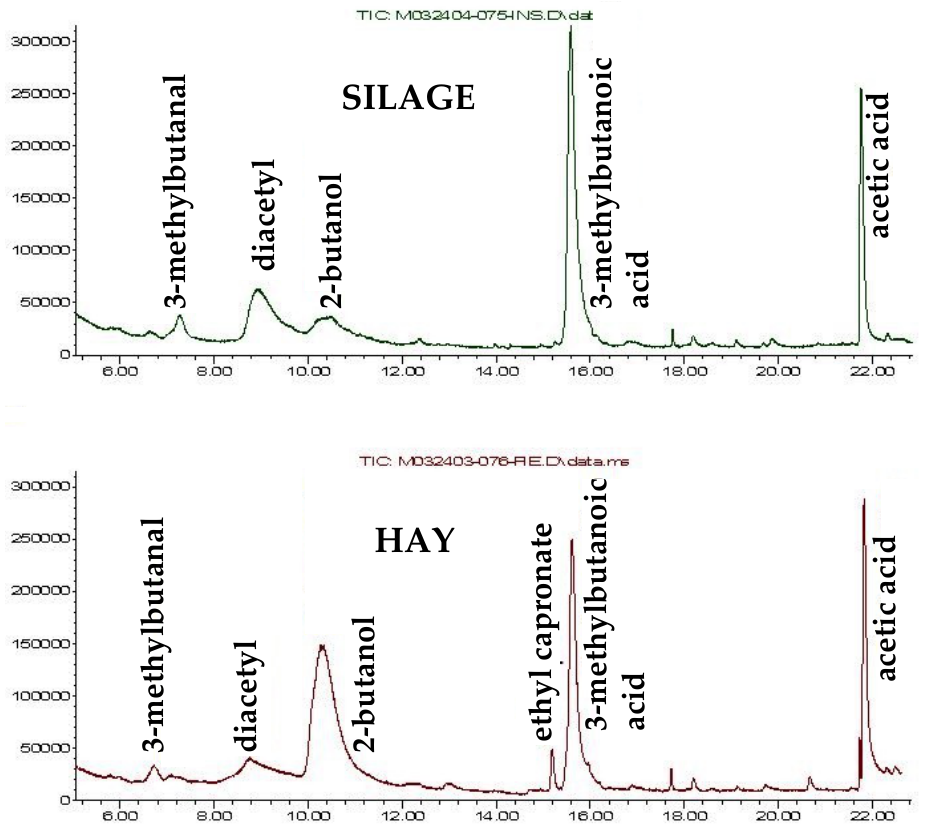
Figure 1. Chromatogram of total ionic current from dynamic headspace coupled for the two cheese typologies.